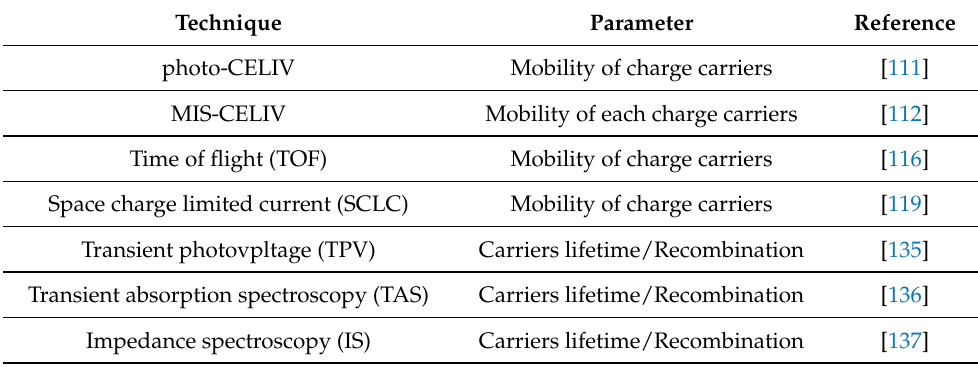
Table 4. Experimental techniques for measuring mobility and carrier